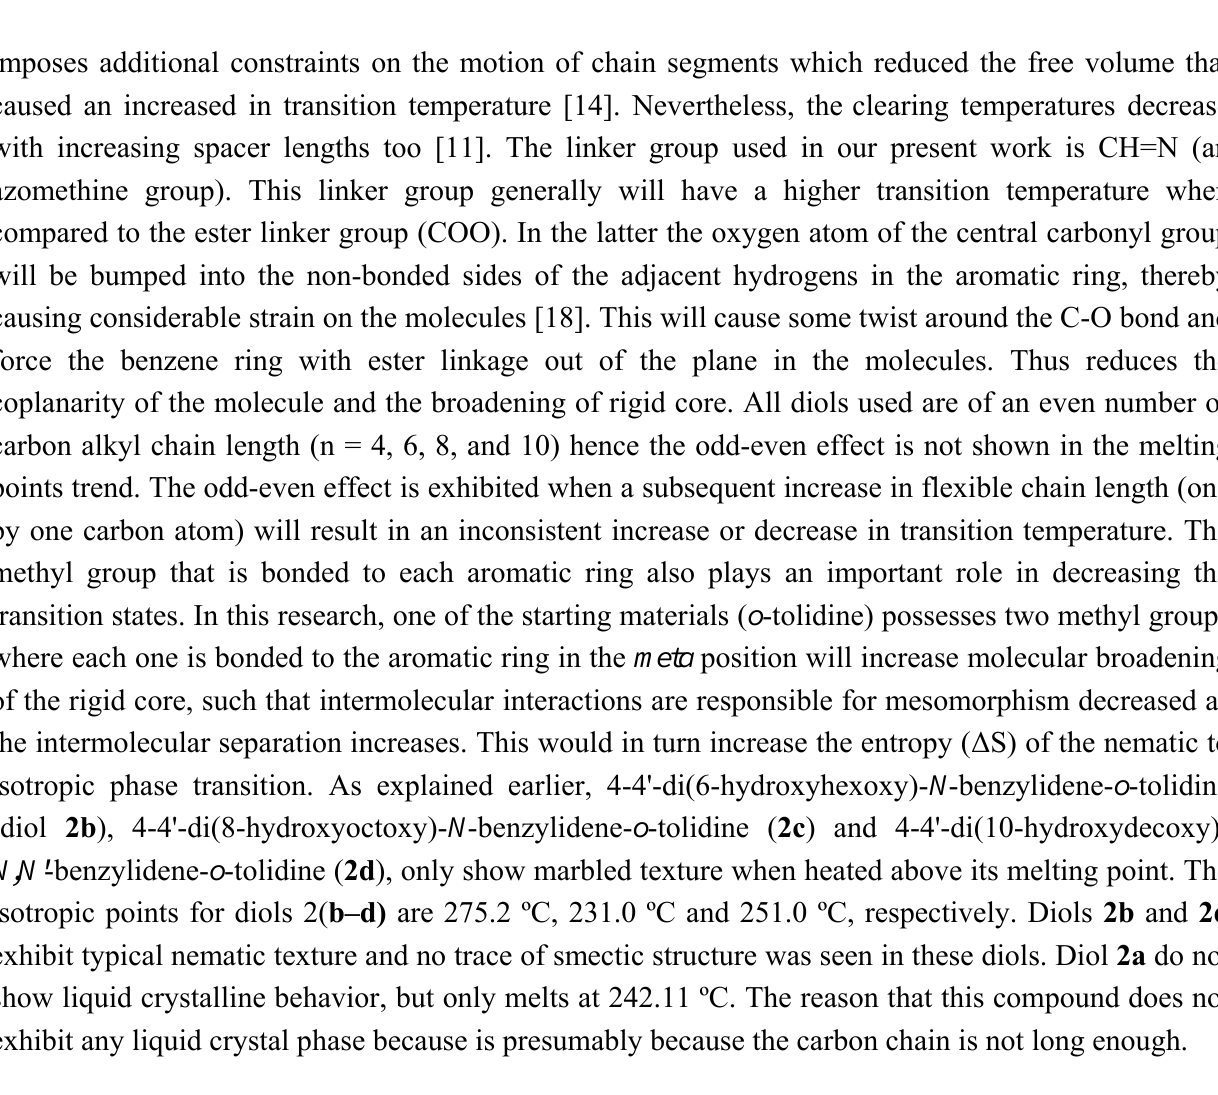
Table 2. Transition temperatures of diols 2 (a–d